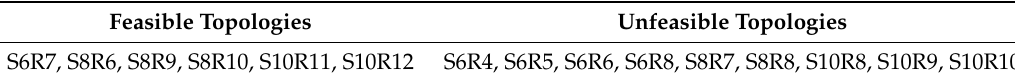
Table 4. Topologies separated based on the results of Table